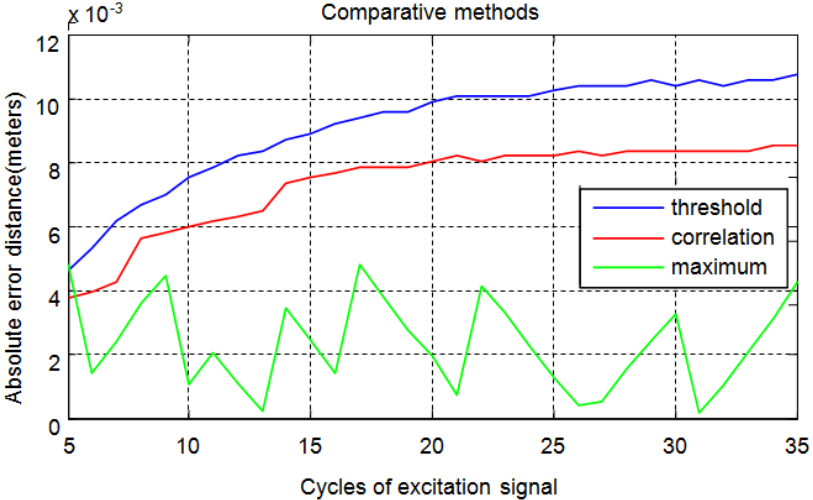
Figure 17. Comparison of absolute average errors in the distance calculation.